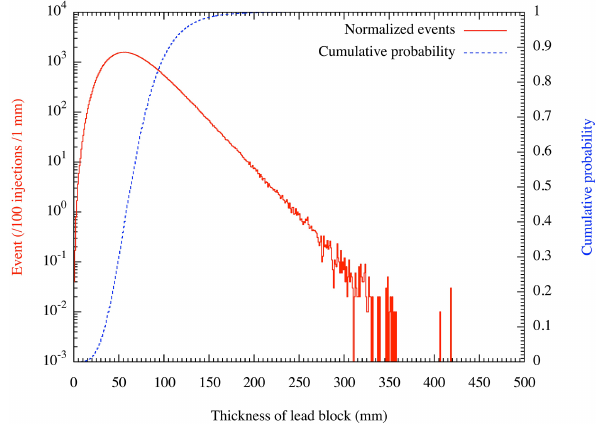
Figure 5. Distribution of the electrons stopped inside a lead block. The incident energy is 100GeV. The stopping probability per 1mm at different depths (red) and the corresponding cumulative probabil- ity (blue) are